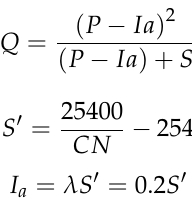
Figure 11. Alluvium and rock delineation in Al ‐ Lusub watershed.